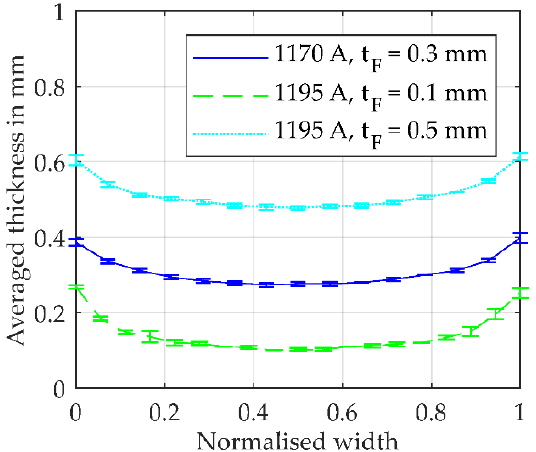
Figure 5. Manufacturing-related thickness variation of TPU films (semi-finished product, full width) and its standard deviation.